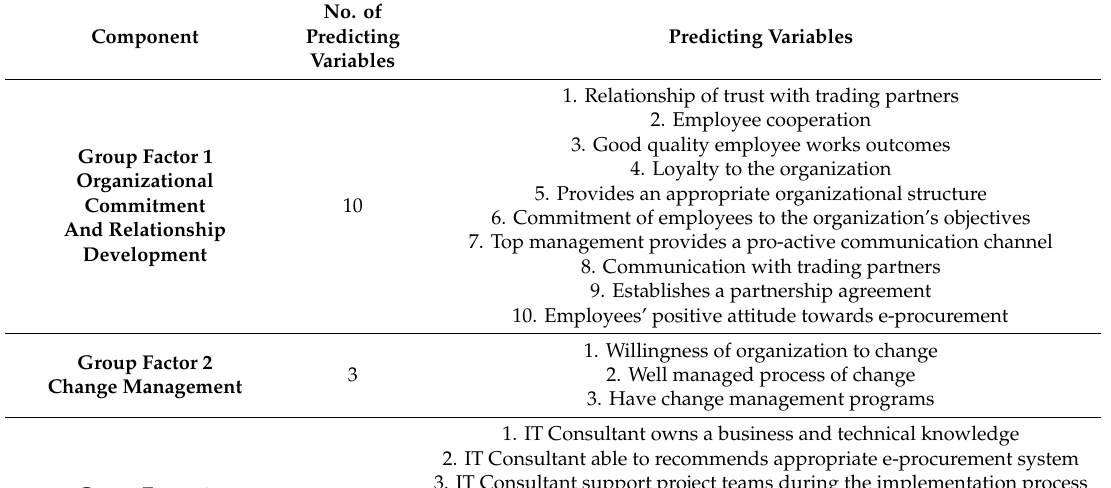
Table 1. Predicting variables of e-procurement implementation